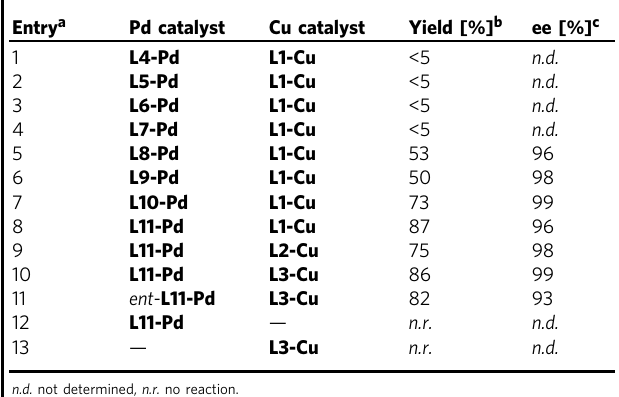
c The ee values were determined by HPLC using a column with a chiral stationary